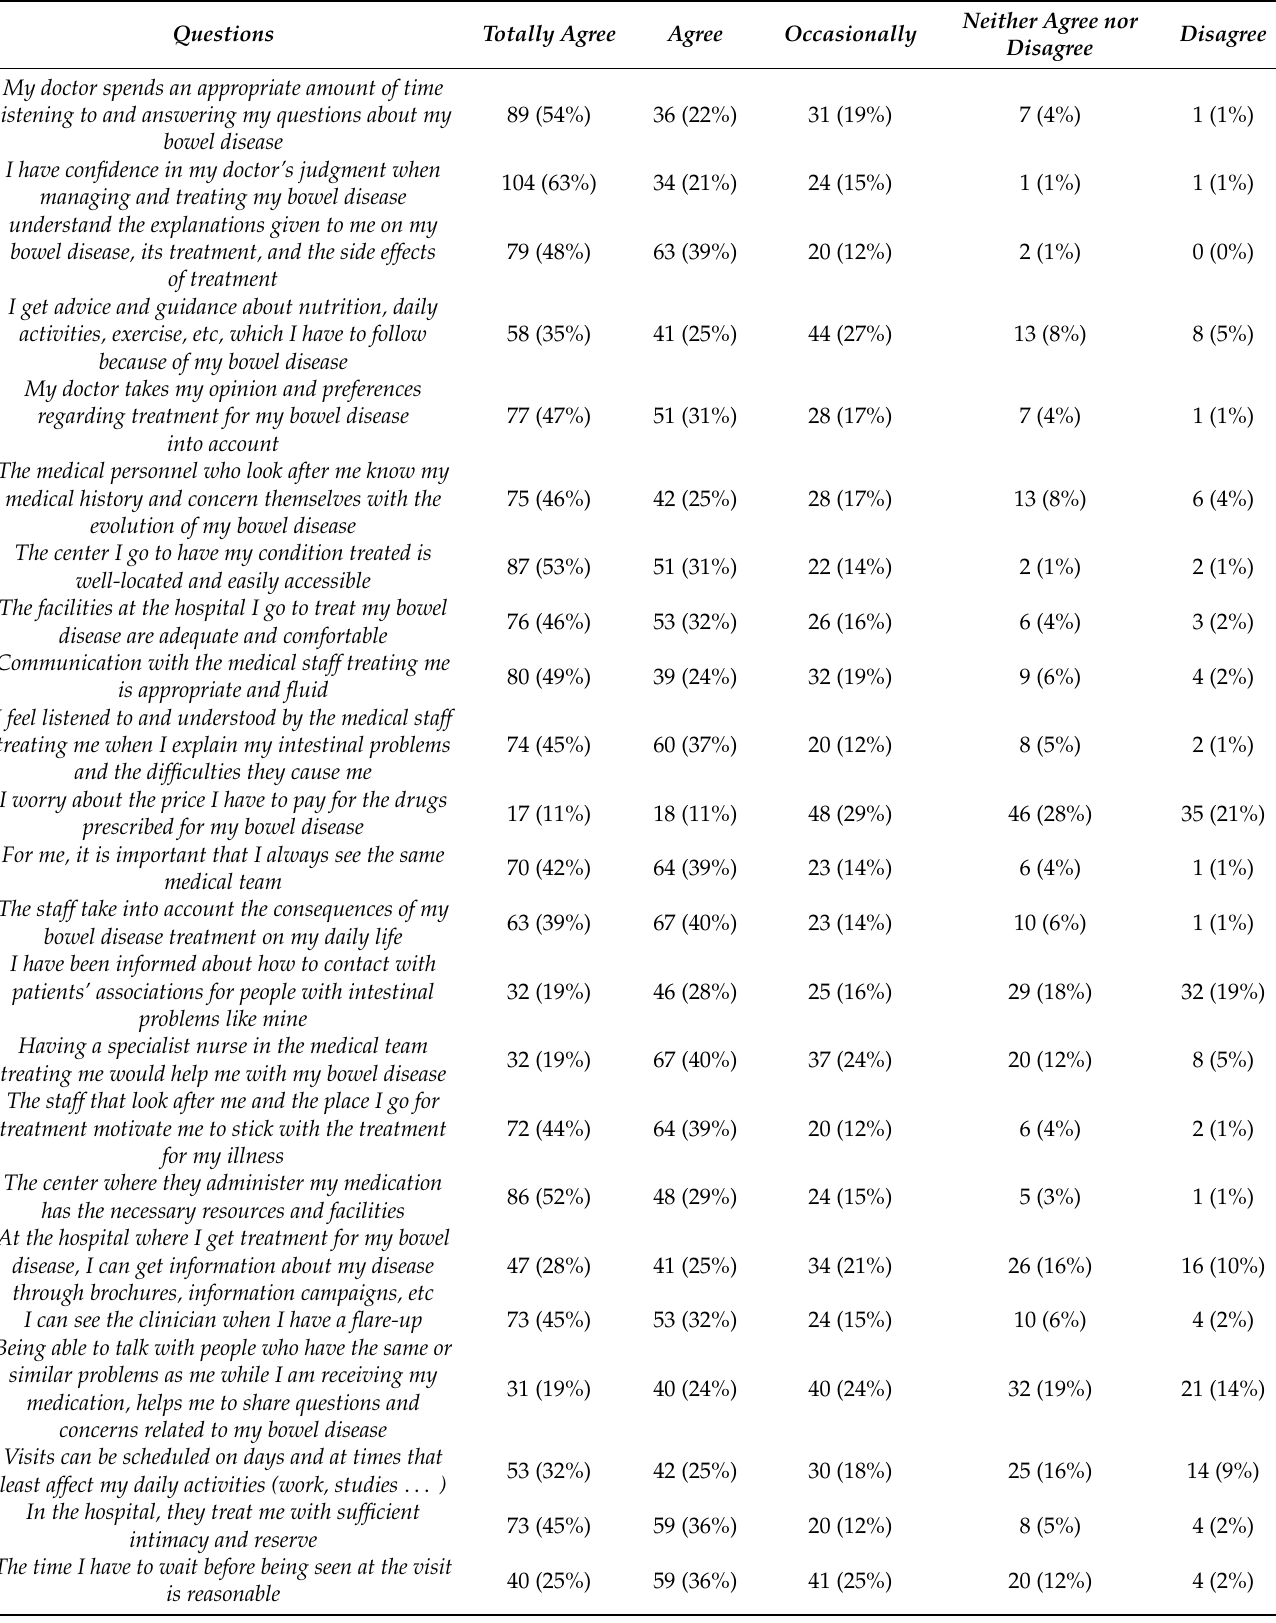
Table 6. Distribution of adult responses in CACHE